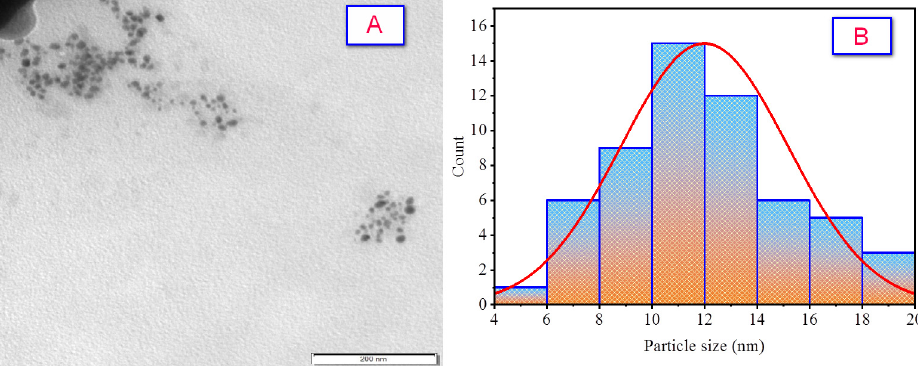
Figure 9. The as-biofabricated Ag NPs: ( A ) TEM image; ( B ) the distribution of particle size.